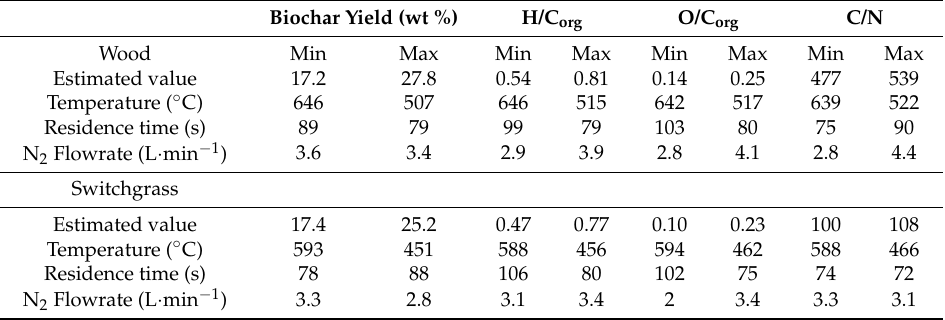
Table 3. Estimated values of biochar properties and estimation of optimal pyrolysis operating parameters from the response surface